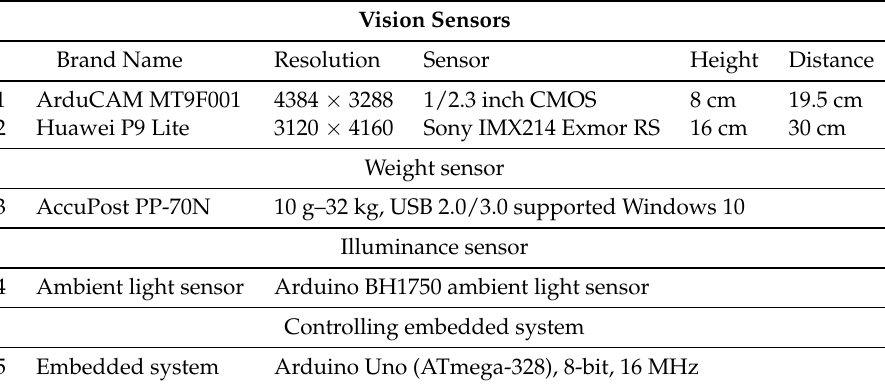
Table 2. Description of multiple sensors used for building the laboratory setup as a prototype of images based on supermarket self-checkouts for weight and image data acquisition.